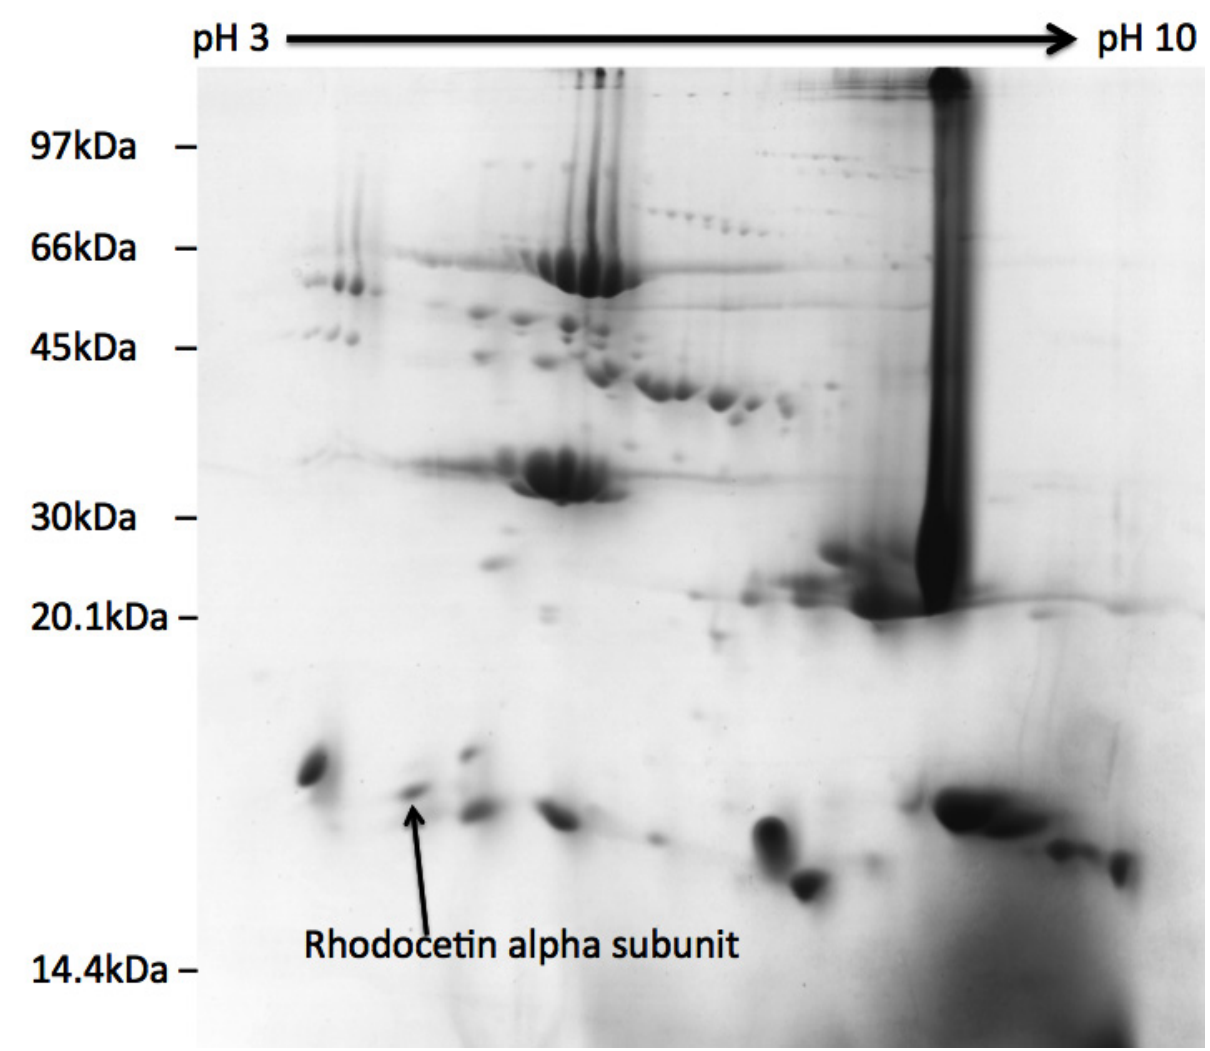
Figure 1. Two-dimensional gel electrophoresis profile of CR (60 m g of protein) highlighting the rhodocetin (αsubunit) spot. The profile was obtained by IEF on a 7-cm IPG strip (pH 3-10) and the proteins subsequently separated in the second dimension by 15% SDS-PAGE. The separated proteins were visualized by Coomasie brilliant blue